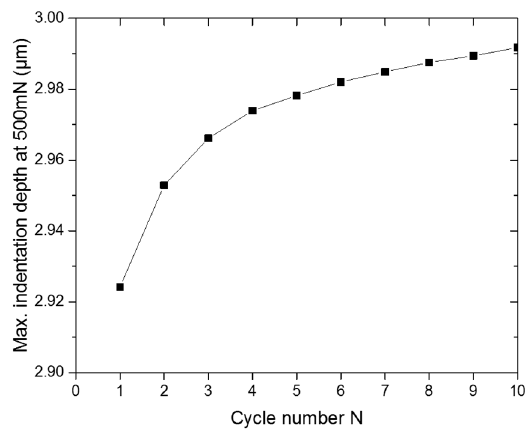
Figure 5. Dependence of maximum indentation depth (at F max ) on the indentation cycle number in the experiment.